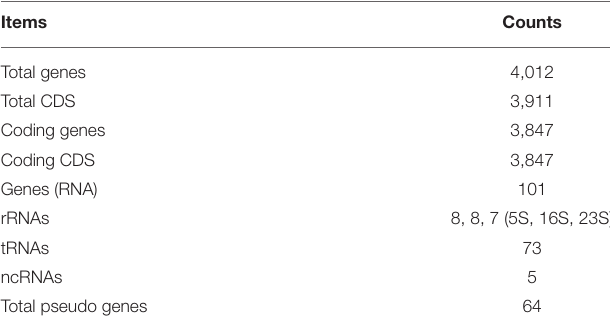
TABLE 1 | Genomic features of Bacillus amyloliquefaciens strain CB annotated using National Center for Biotechnology Information—Prokaryotic Genome Annotation Pipeline (NCBI-PGAP) v.